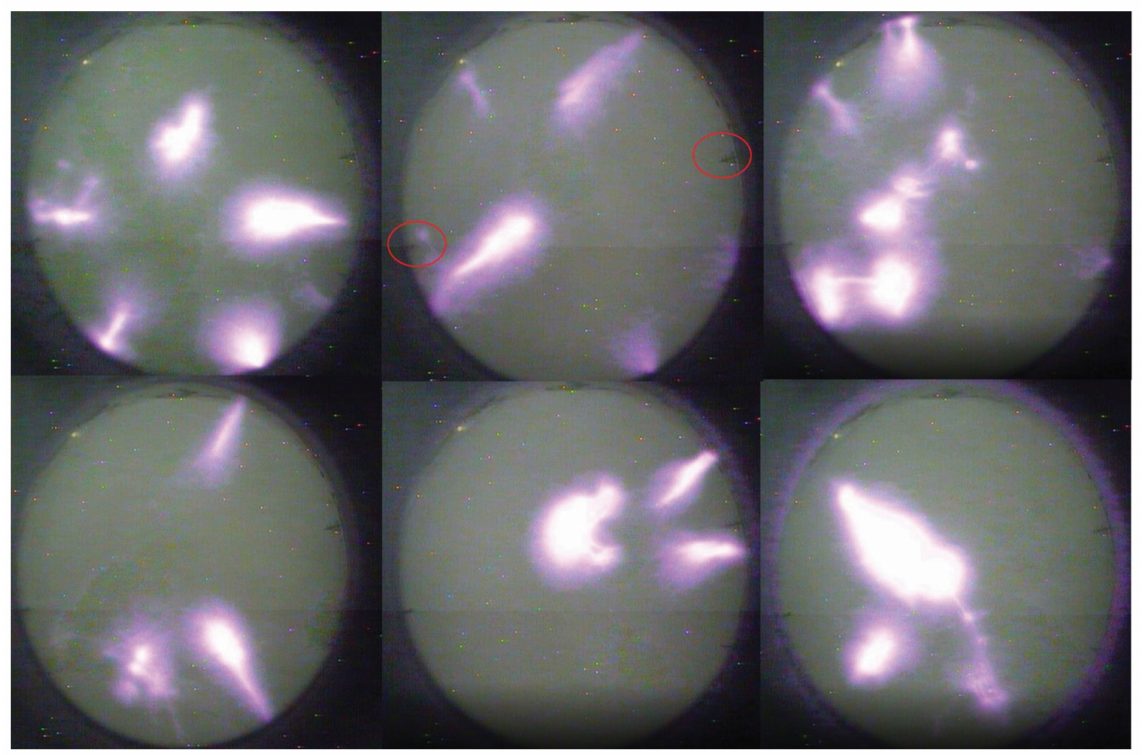
Figure 8. Selected light glows occurred during maximum minutes of TGE (19:19–19:21), the full collection available from the 1 s clips [40]. With red ovals, we denote the two highest metallic structures on the station: the mast behind the MAKET experimental hall, and the chimney behind the hotel building, shown in Figure 9.